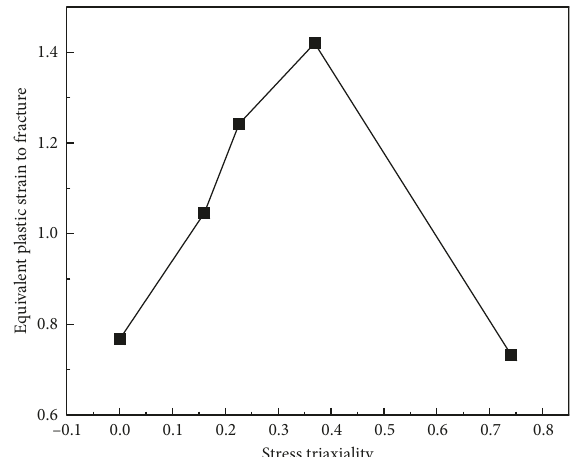
Figure 15: Actual initial stress triaxialities coupled with equivalent plastic strains to fracture.